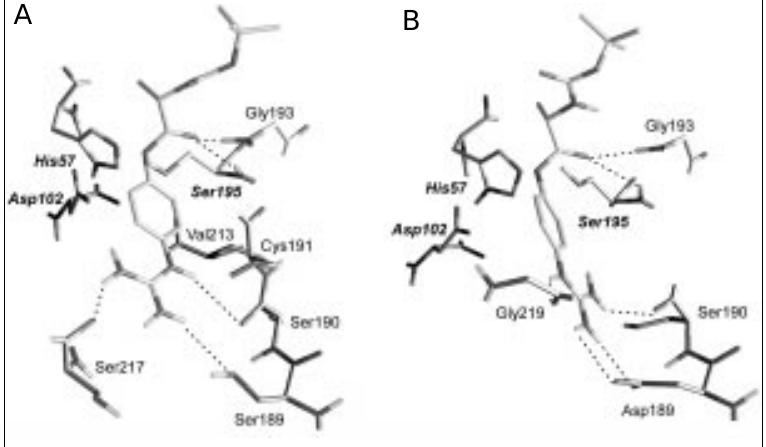
Figure 8 - Arrangements of Boc- L -Ala-OGp at the active sites of chymotrypsin (A) and trypsin (B) derived from the lowest-energy complexes (Günther R, Thust S, Hofmann H-J and Bordusa F, unpublished results). Shown are the amino acid residues of the enzymes which either form hydrogen bonds (Asp189/Ser189, Ser190, Ser217/Gly219) or have catalytical functions ( His57 , Asp102 , and Ser195 ).